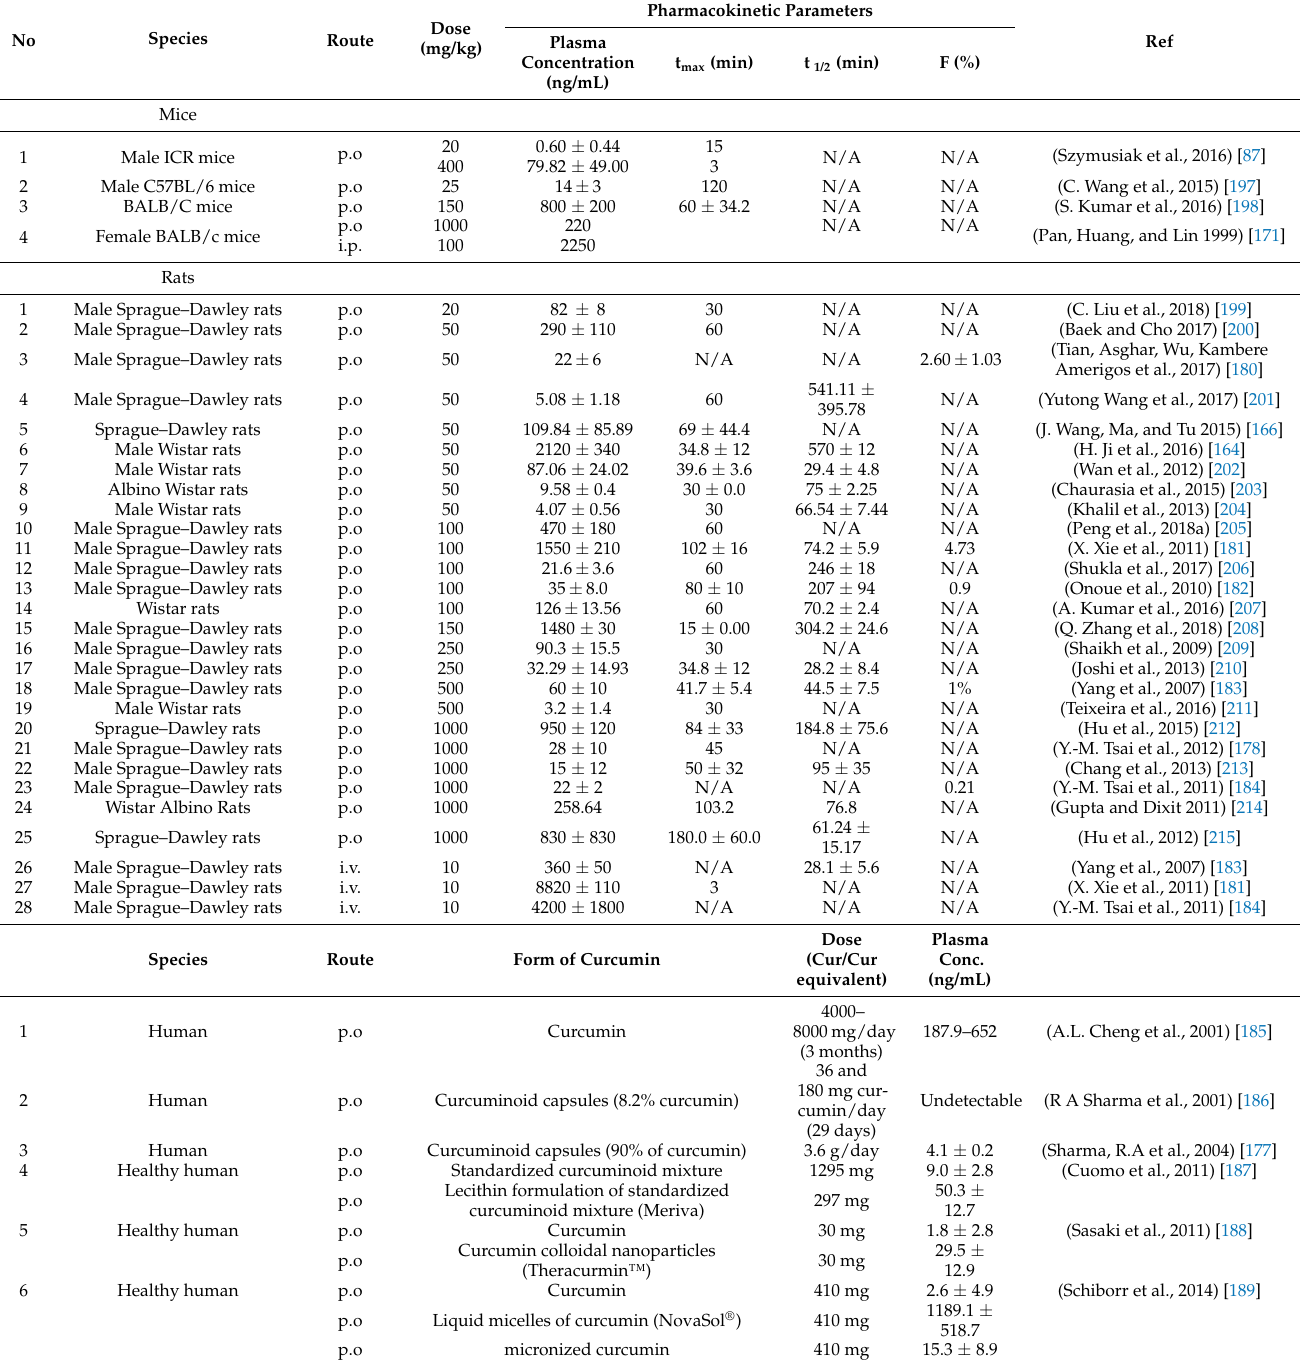
Table 5. Plasma pharmacokinetics of